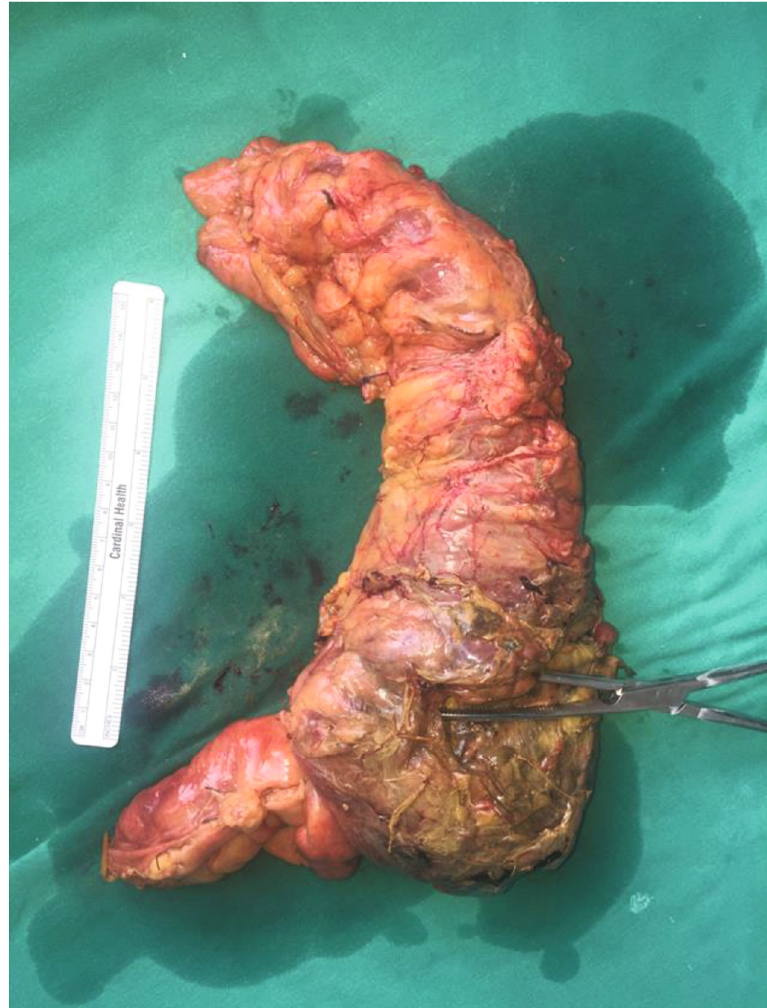
Figure 3: The right hemicolectomy specimen as it appears from the posterior side. A clamp is placed on the site of the